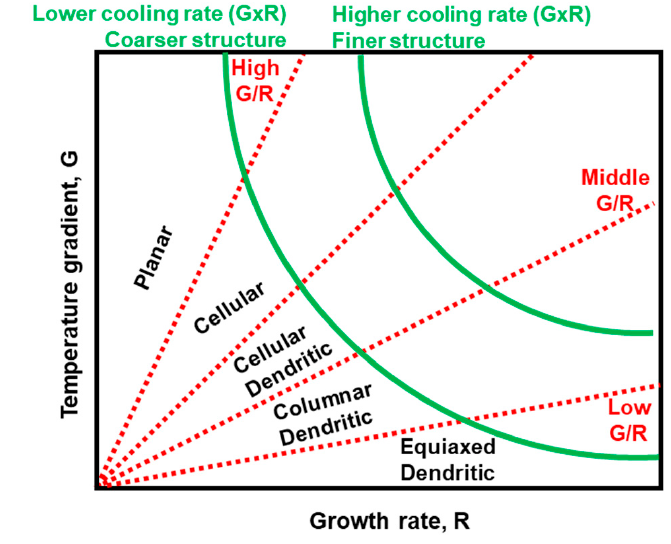
Figure 4. Solidification map: effect of temperature gradient (G) and growth rate (R) on morphology and size of solidification microstructure [21] .